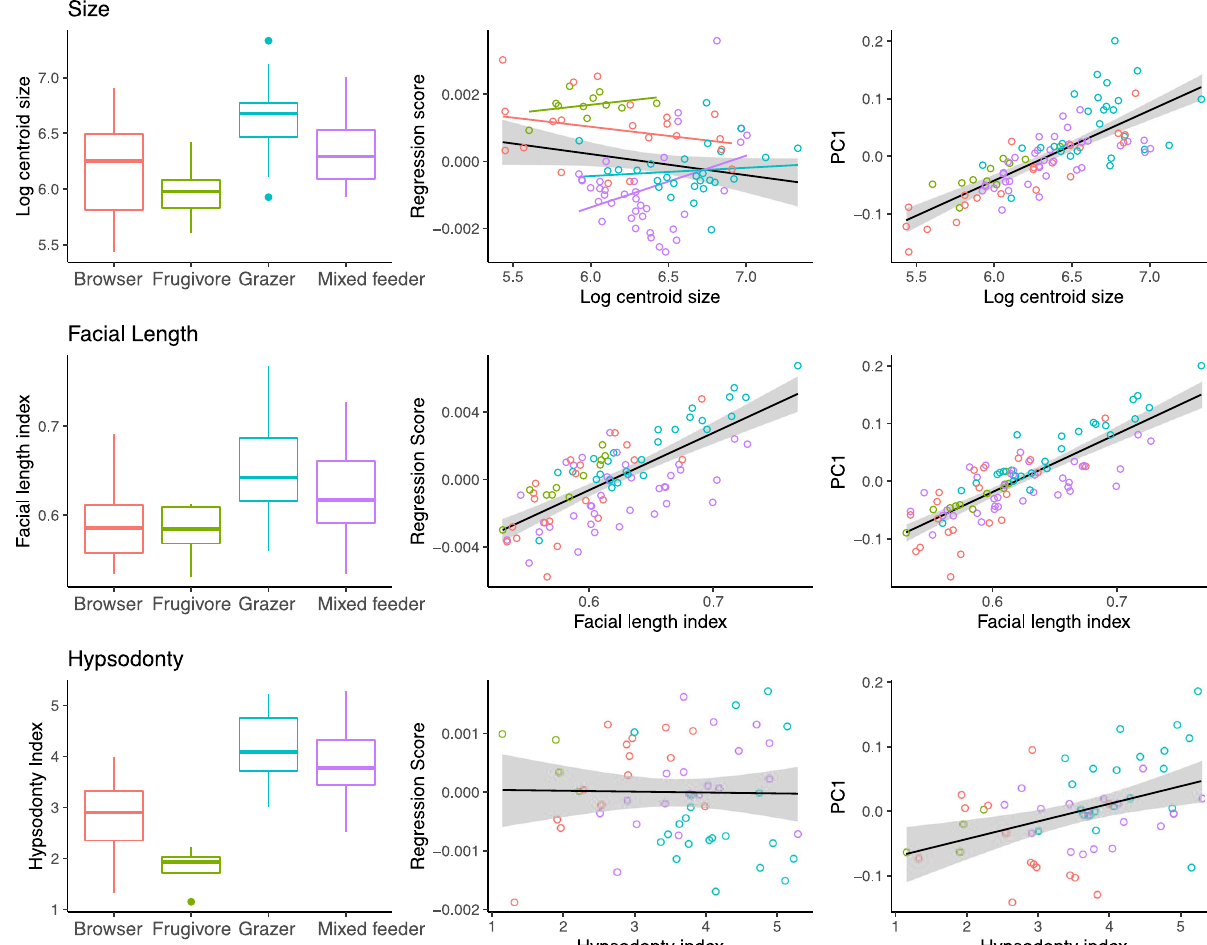
Fig. 7 Relationships of size, hypsodonty, and facial elongation to diet and shape (regression score of shape against each variable). All three traits are signi fi cantly correlated with dietary differences as well as with total shape and PC1. These traits explain dietary differences better than total shape, and size and facial length together account for over 80% of the variance in PC1 (see the text). Differences in size-shape allometry (slopes) among dietary categories are signi fi cant, with pairwise tests distinguishing frugivores (i.e., Cephalophini) from all other categories and browsers from mixed